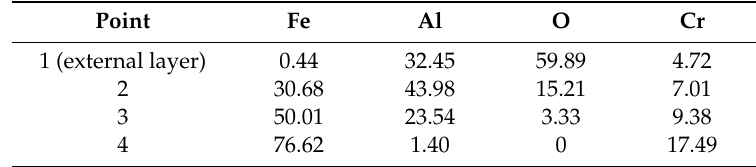
Table 2. Energy dispersive spectrometer (EDS) analysis of different regions in aluminized coating (white points in Figure 2b), (at. %).